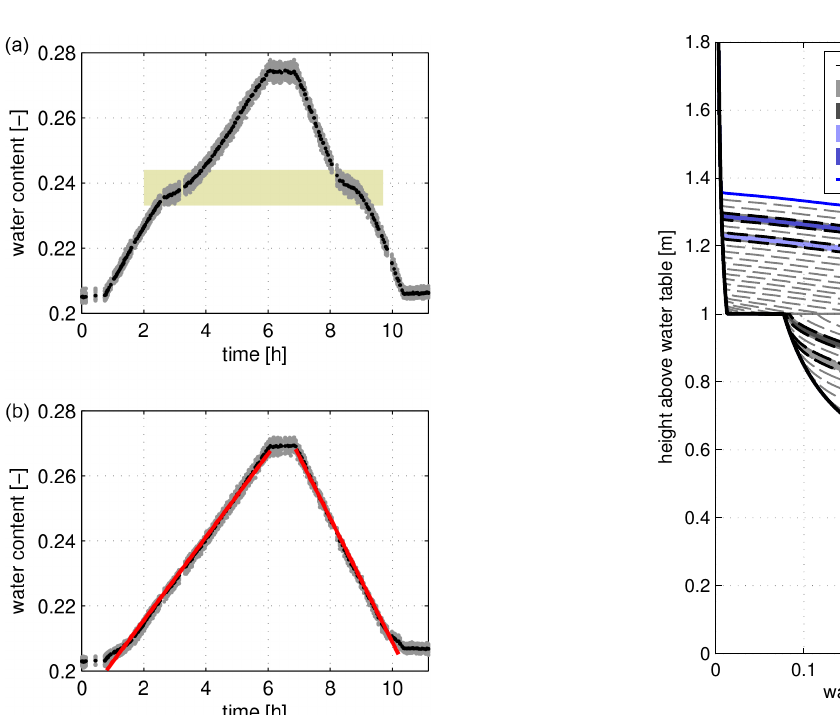
Figure 8. (a) Soil water content calculated from the bottom reflec- tion travel time during experiment 1 in the two-layered region. The black dots denote results averaged over a 2m stretch of the two- layered region (as indicated in Fig. 1), and the grey dots show all values measured along this stretch. The yellow shaded area denotes the water content change during time intervals in which the capil- lary fringe adapts while crossing the material boundary. This behav- ior is illustrated for the imbibition branch in Fig. 9. (b) Soil water content calculated from the bottom reflection travel time during ex- periment 1 in the region of the synclinal structure. The black dots denote results averaged over a 2m stretch in this region (as indi- cated in Fig. 1), and the grey dots show all values measured along this stretch. The red lines indicate a linear fit to the imbibition and drainage branches of the averaged soil water dynamics.